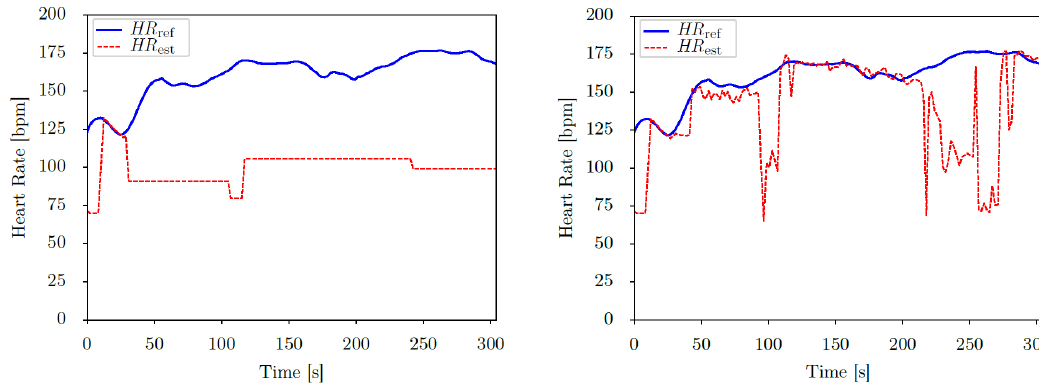
Figure 4. IEEE_Training dataset, session S10: comparison of ground truth ( HR ref ) and estimated ( HR est ) heart rate. Left plot: heart rate estimation with the SpaMa -approach, right plot: heart rate estimation with the SpaMaPlus